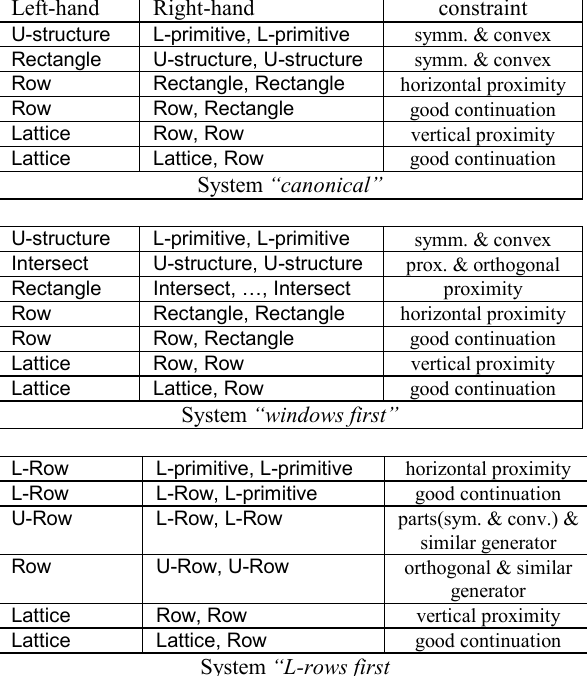
Table 1. Production